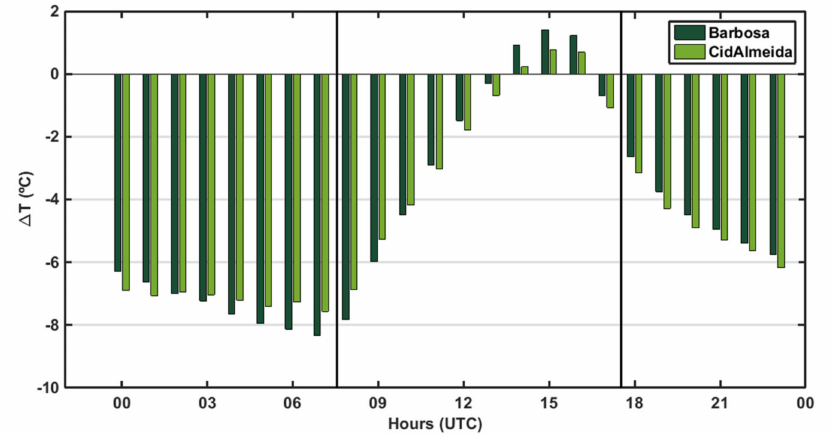
Figure 12. Daily cycle of the temperature difference between air temperature in the shore stations and water temperature at 0.5 m depth in Montante during January 2019. Grey vertical lines indicate the sunrise and sunset.